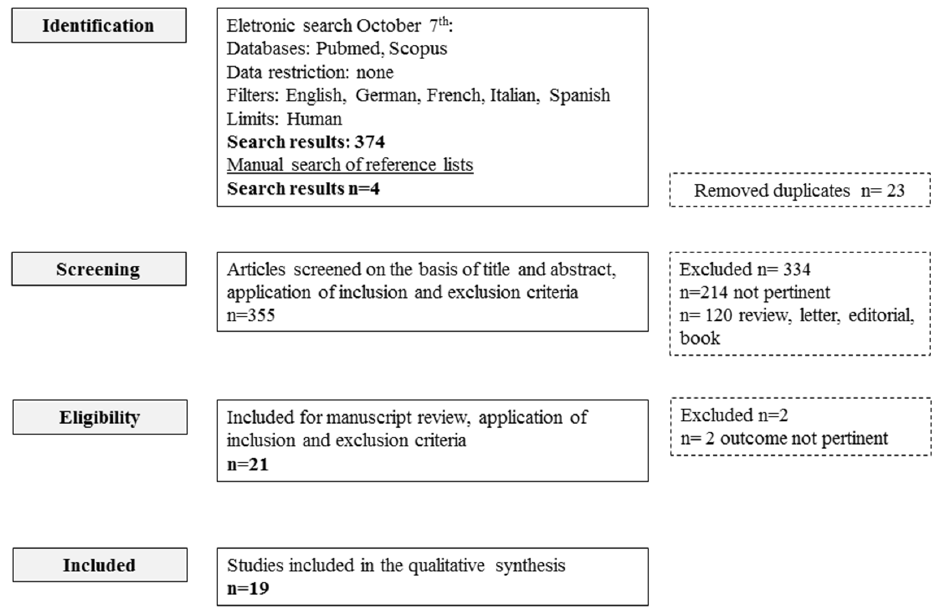
Figure 1. Flow-chart of study selection. Figure 1. Flow ‐ chart of study selection.